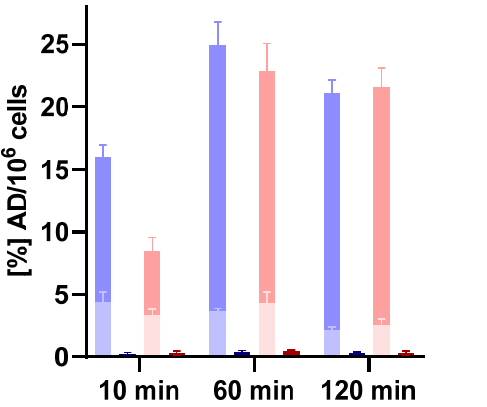
Figure 2. Cell binding and internalization of radiolabeled bombesin derivatives [ 99m Tc][Tc(CO) 3 ( 12 )] and [ 99m Tc][Tc(CO) 3 ( 13 )] using GRP-receptor expressing PC-3 cells; non-specific binding was determined with 1000-fold excess of BBN(1 – 14). Values are the mean ± SD ( n = 2–3 in triplicate) and data are normalized to 10 6 cells per well.